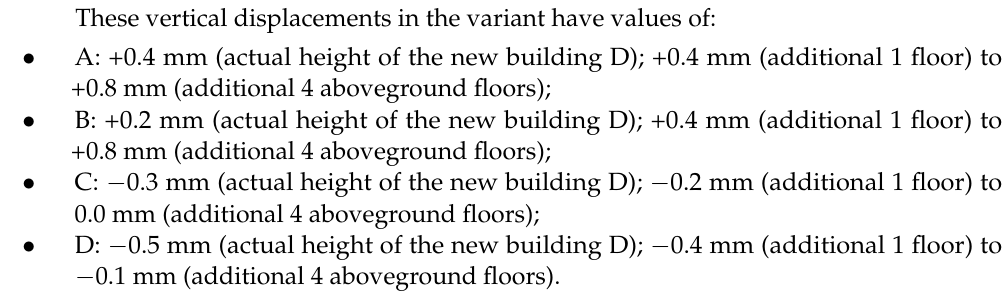
Table 3. The results for the final vertical displacements of the building at 1B Ludna Street at the site of benchmark Rp30 in the case of actual variant A of the underground part in the cases of virtual variants B, C, and D and increasing the number of additional overground floors from 0 to 4. Number of Additional Overground Floors +0 +1 +2 +3 +4 Variant [mm] [mm] [mm] [mm] [mm] Variant A − 3.0 − 3.8 − 4.5 − 5.2 − 5.9 Variant B − 3.1 − 3.8 − 4.5 − 5.3 − 6.0 Variant C − 4.3 − 4.9 − 5.5 − 6.1 − 6.6 Variant D − 5.3 − 5.9 − 6.4 − 7.0 −